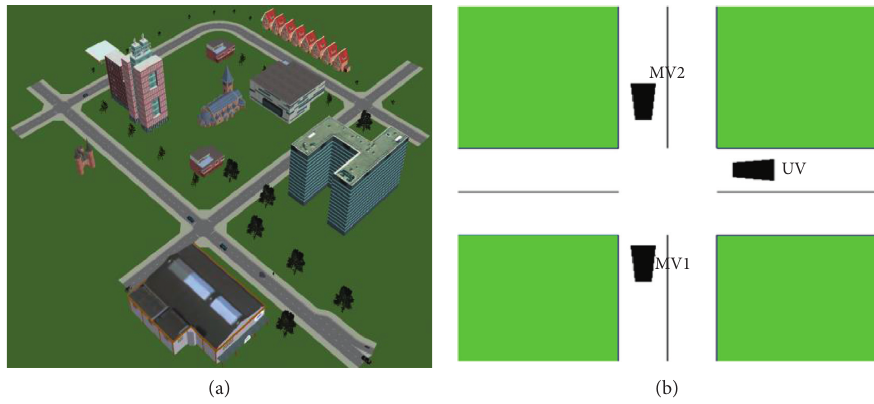
Figure 7: Simulation platform. (a) PreScan. (b) OpenAI